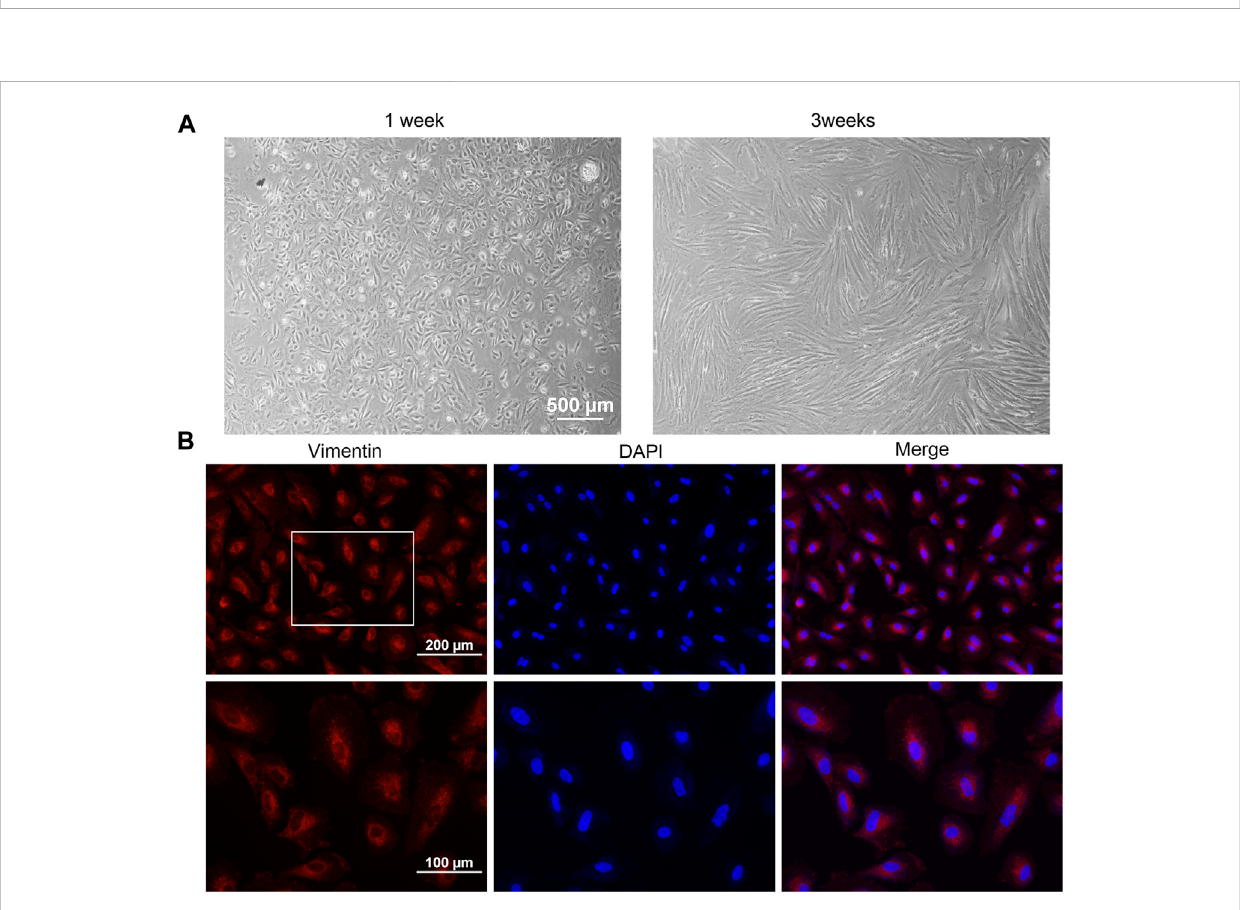
FIGURE 2 Cell culture and identi fi cation. (A) Cell morphology of AMESCs. (B) Cell identi fi cation assay of Vimentin (Red) and DAPI